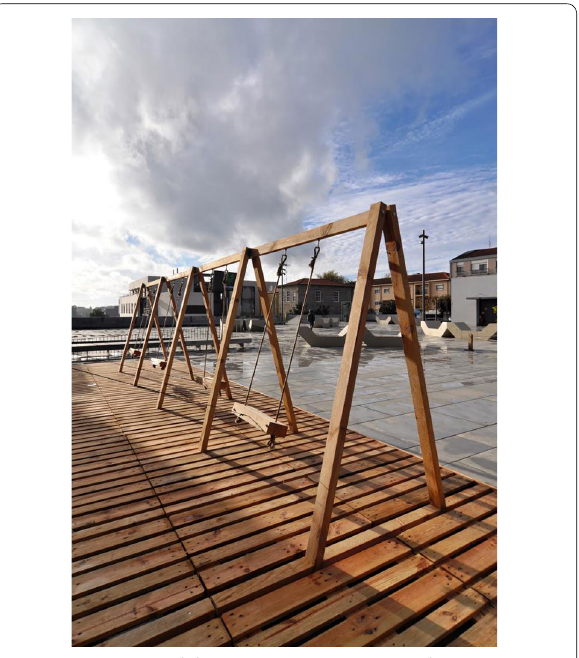
Fig. 6 Temporary and demonstrative systems: Moradavaga SWING, electricity generation swing (from http://www.morad avaga .com)